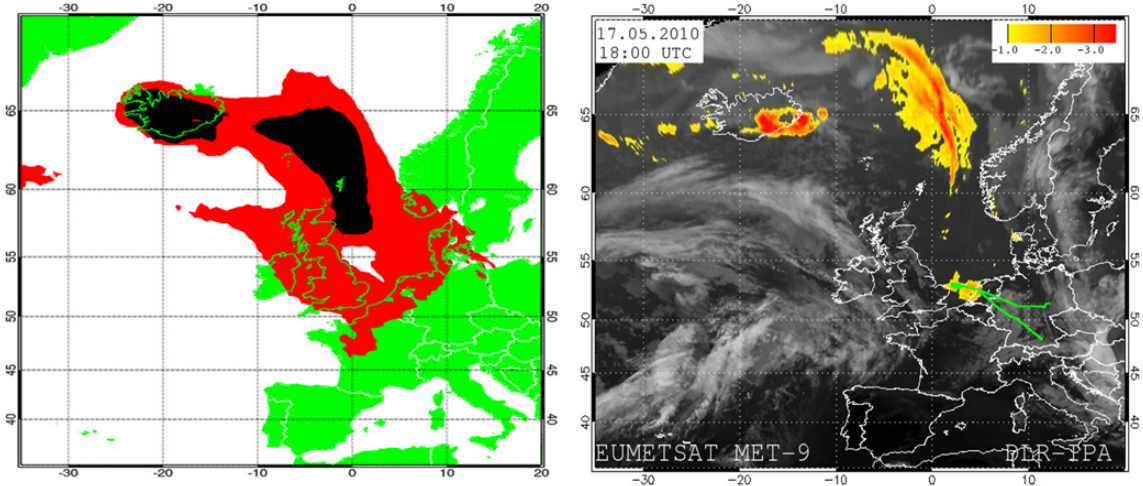
Fig. 15. VAAC prediction (issued at 18:00UTC 17 May 2010) and Meteosat VA analysis including the Falcon flight path (green curve) for 18:00UTC 17 May 2010.